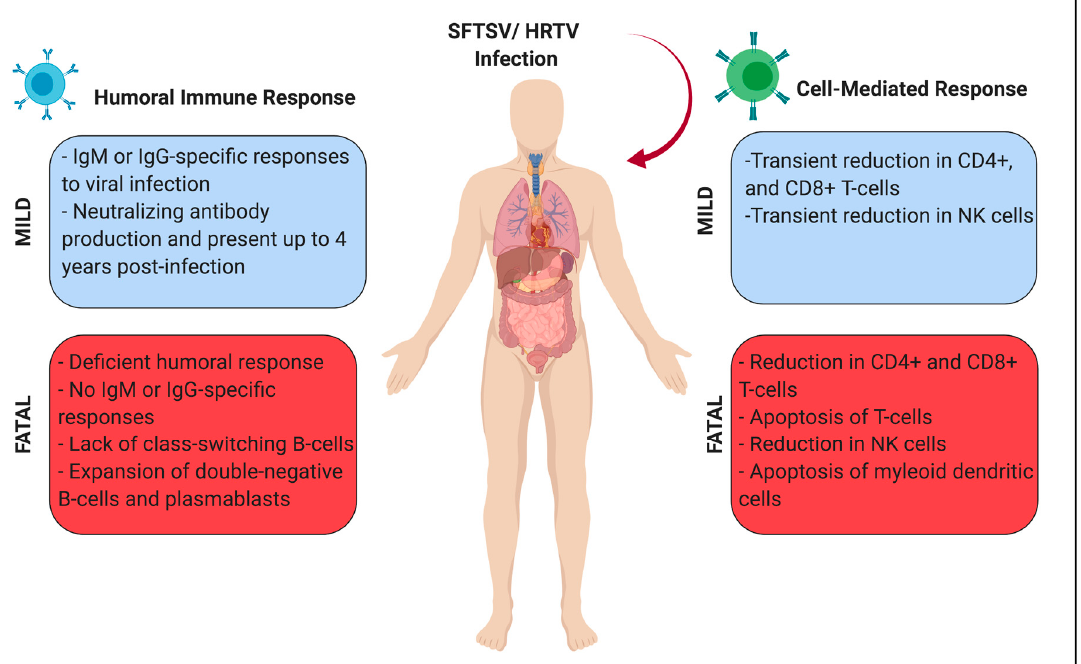
Figure 5. Adaptive Immune Response during SFTSV and HRTV infection. The humoral and cell ‐ mediated responses are described. Fatal patients exhibit a lack of efficient antibody production coupled with the reduction of CD4+ and CD8+ T ‐ cells indicating dysfunction of mounting a robust immune response. Neutralizing antibody responses can be detected years post ‐ hospitalization.